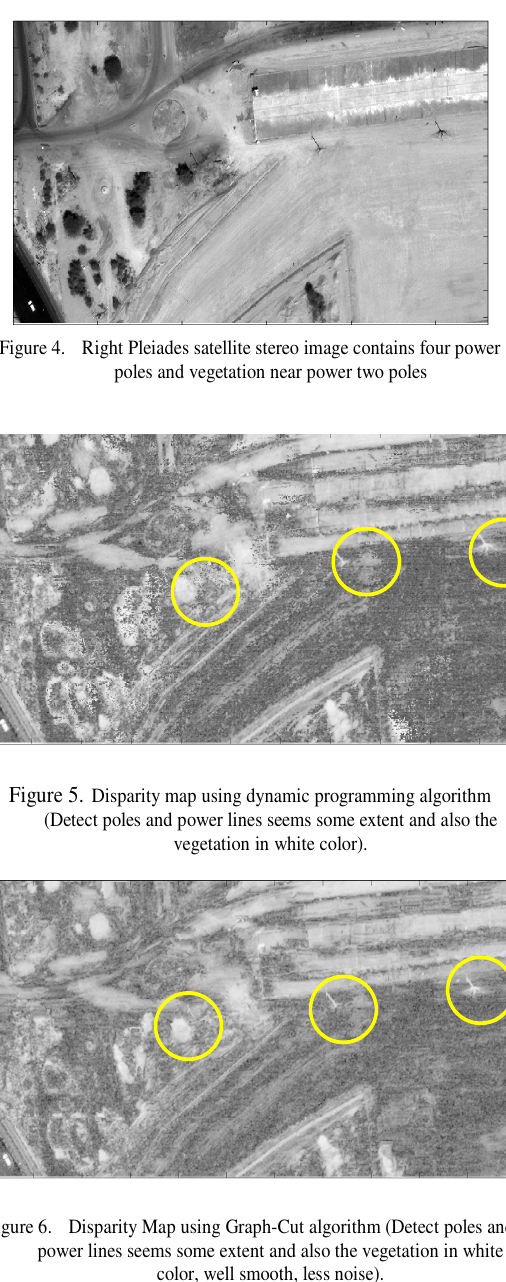
Figure 3. Reference satellite Pleiades satellite stereo image contains four power poles and vegetation near power two poles.